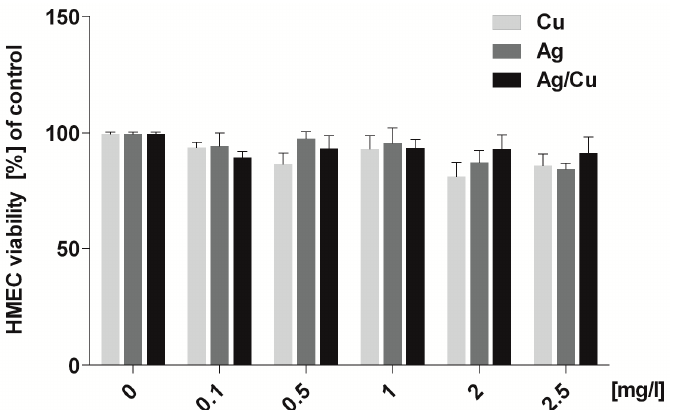
Figure 2. Oxidoreductive activity of HMEC cells, calculated using PrestoBlue test (no statystical differences).